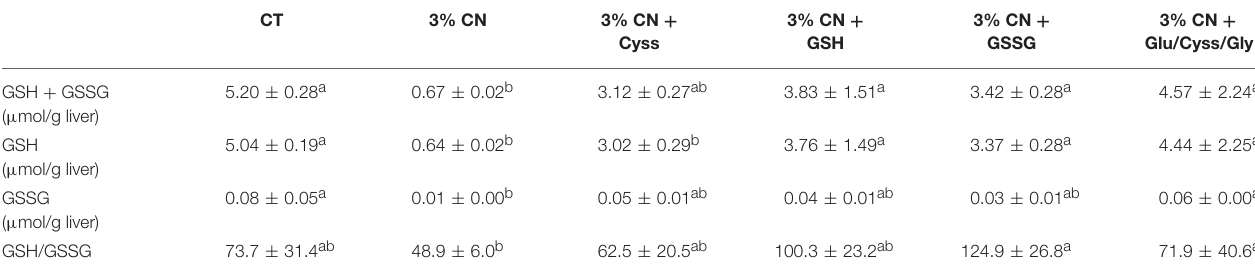
TABLE 4 | Hepatic glutathione status in Experiment 3.